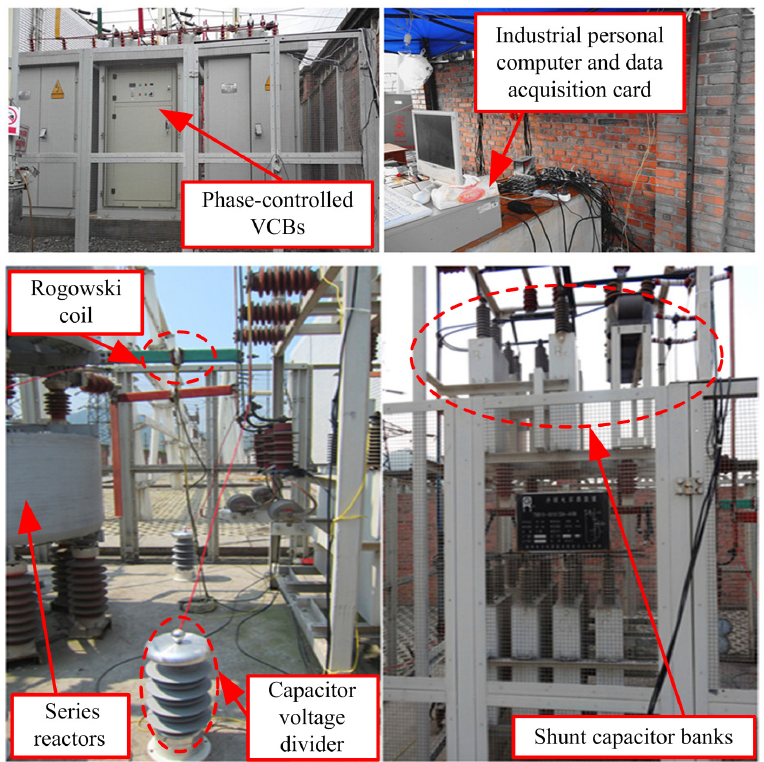
Figure 6. Site layout of the field tests in a 110 kV substation.